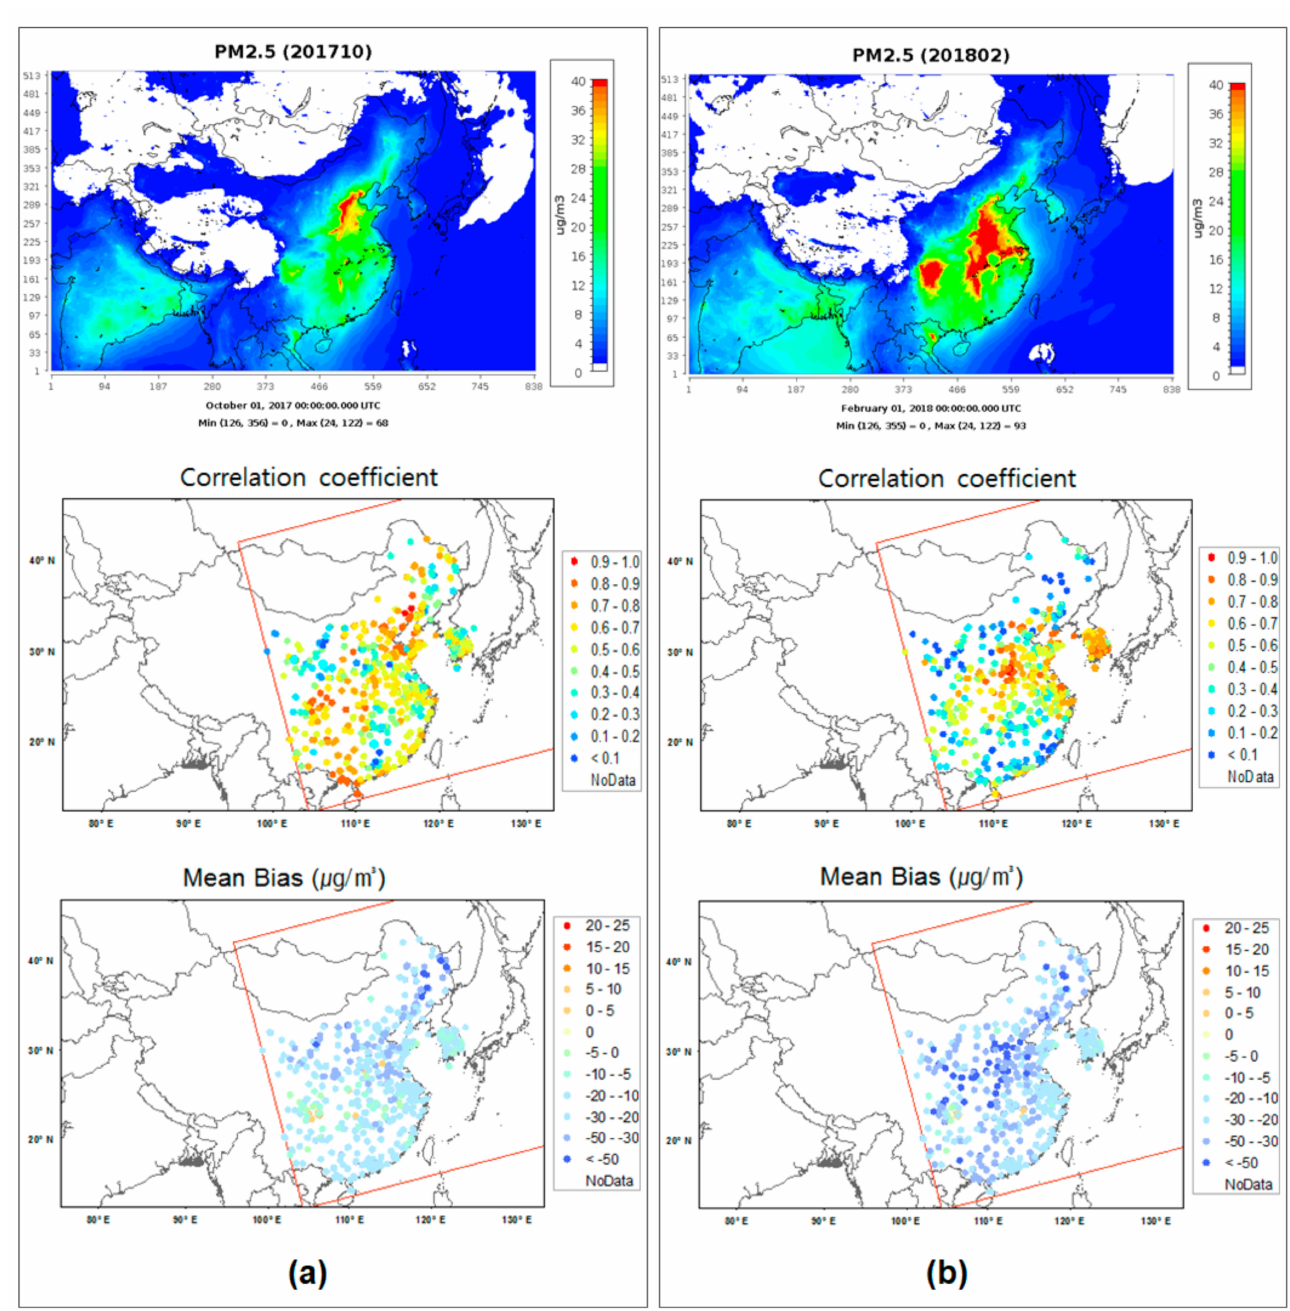
Figure 4. The NR results for ( a ) October 2017 and ( b ) February 2018. Top figures: the distribution of the monthly averages of the simulated PM 2.5 mass concentrations in NR. Mid-figures: the correlation coefficients between the NR PM 2.5 concentration and the ground-observed PM 2.5 concentration at the surface monitoring sites. Bottom figures: the mean bias of the simulated PM 2.5 mass